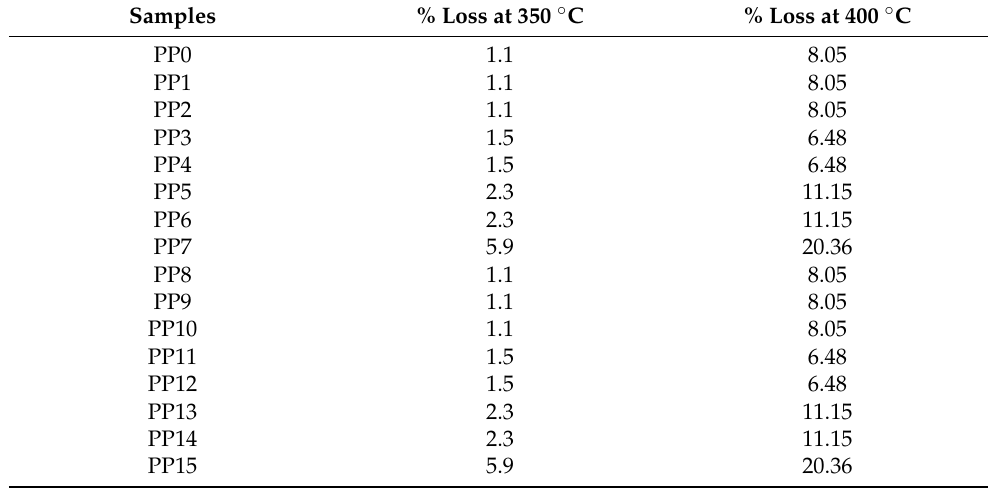
Table 2. Loss of mass for acetylene and methyl acetylene samples at temperatures ranging from 250 to 350 ◦ C and 250 to 400 ◦ C,